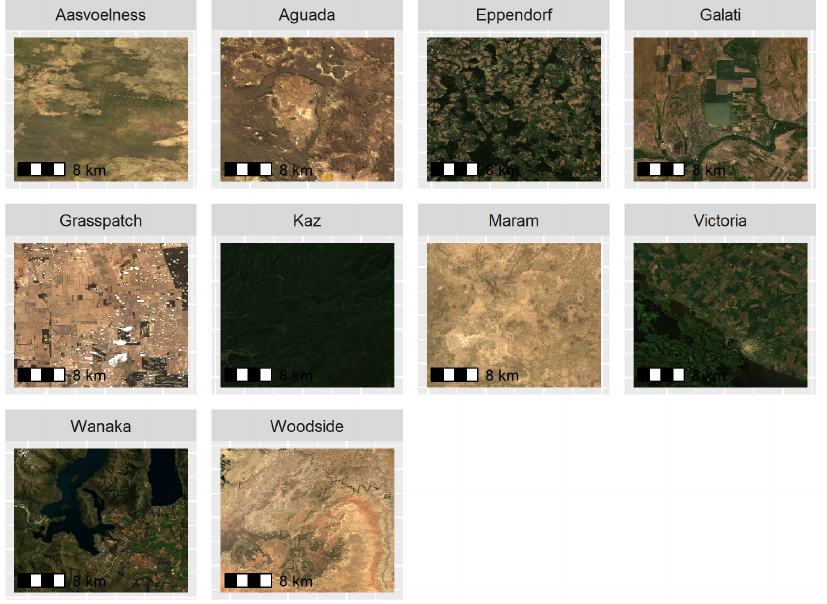
Figure 6. Target datasets used as input for the random forest land cover processing algorithm. One hundred points were sampled on each dataset. Titles are